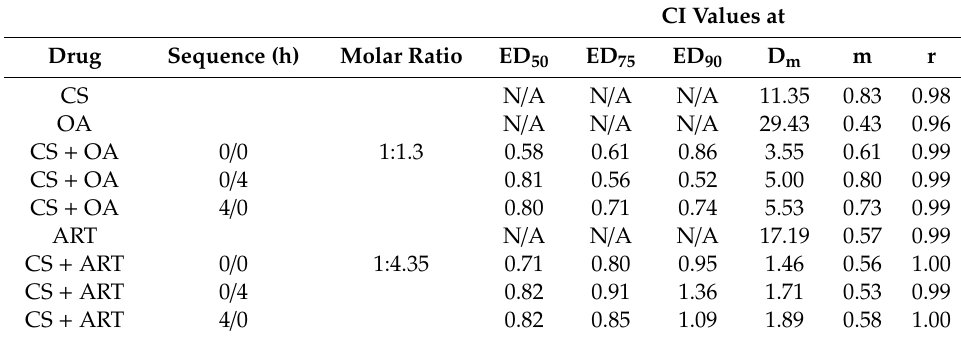
Table 4. CI values of CS with OA and ART in the A2780 ZD0473R cell line where drugs were added in equipotent ratios based on IC 50 values.